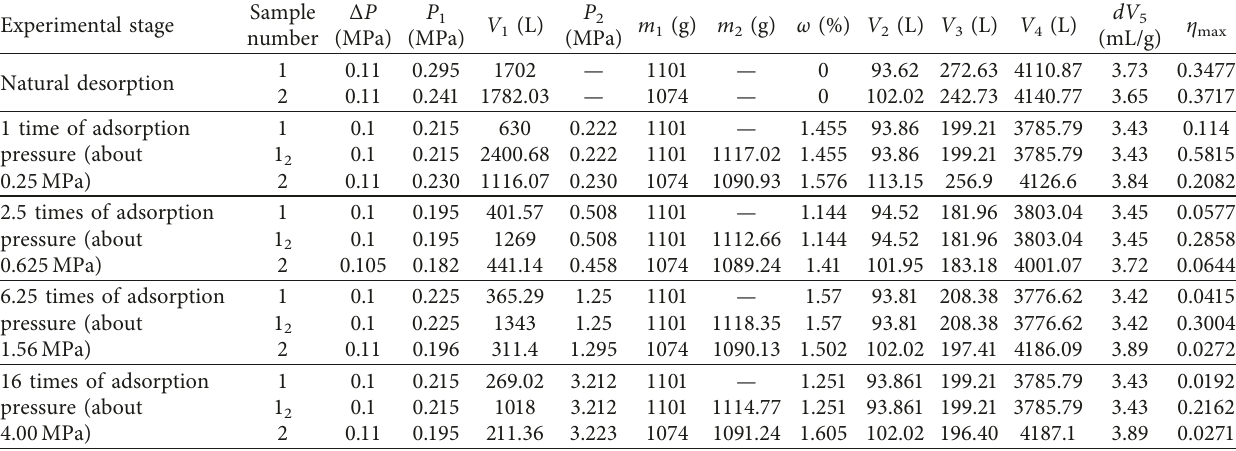
Table 2: Raw data of the two coal samples at gas adsorption pressure around 0.25MPa.